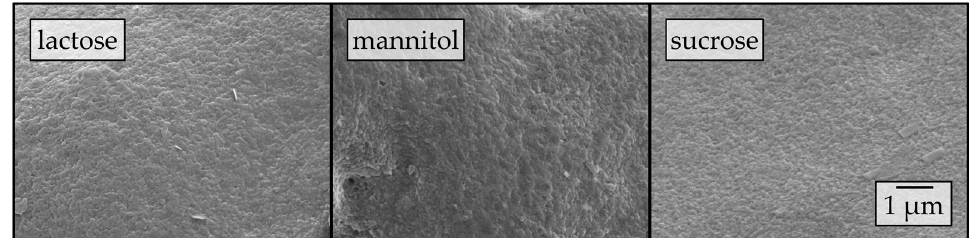
Figure 10. Surface morphologies of granules produced with a nanosuspension (stabilized with HPMC) without additional drying excipients and with the use of lactose, mannitol, and sucrose as carrier materials in a fluidized granulation approach, assessed by SEM.